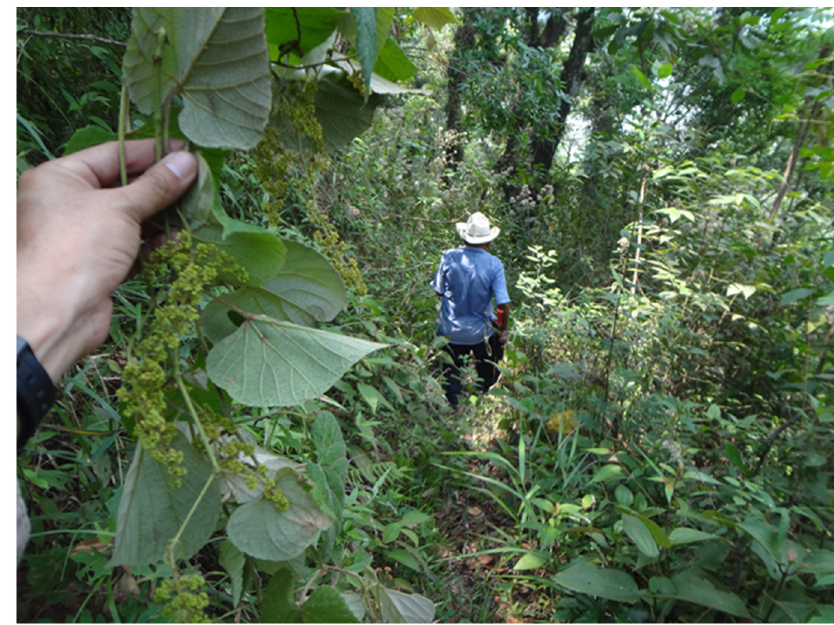
Figure 4. V. tiliifolia collected in localities of Ixtaczoquitlán, Veracruz, México.